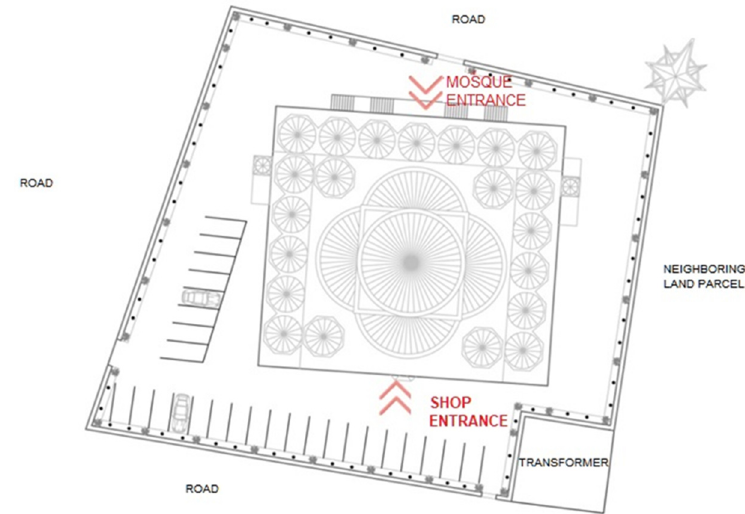
Figure 10. Layout plan of Güzeloba Mosque.